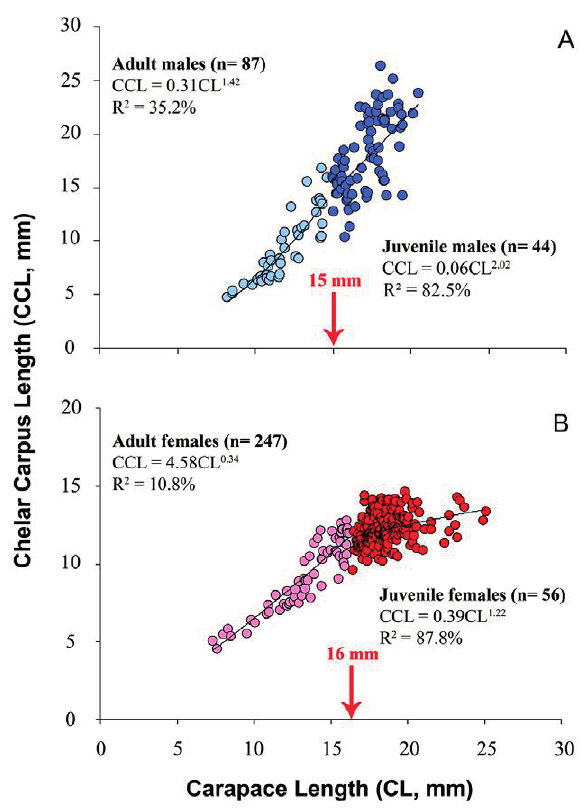
Fig. 3. – Biometric relationship CCL vs. CL, regression analyses of both development phases in males (A) and females (B), and size of morphological maturity. CCL, carpus length of the major cheliped; CL, carapace length; light points, juveniles; dark points, adults.